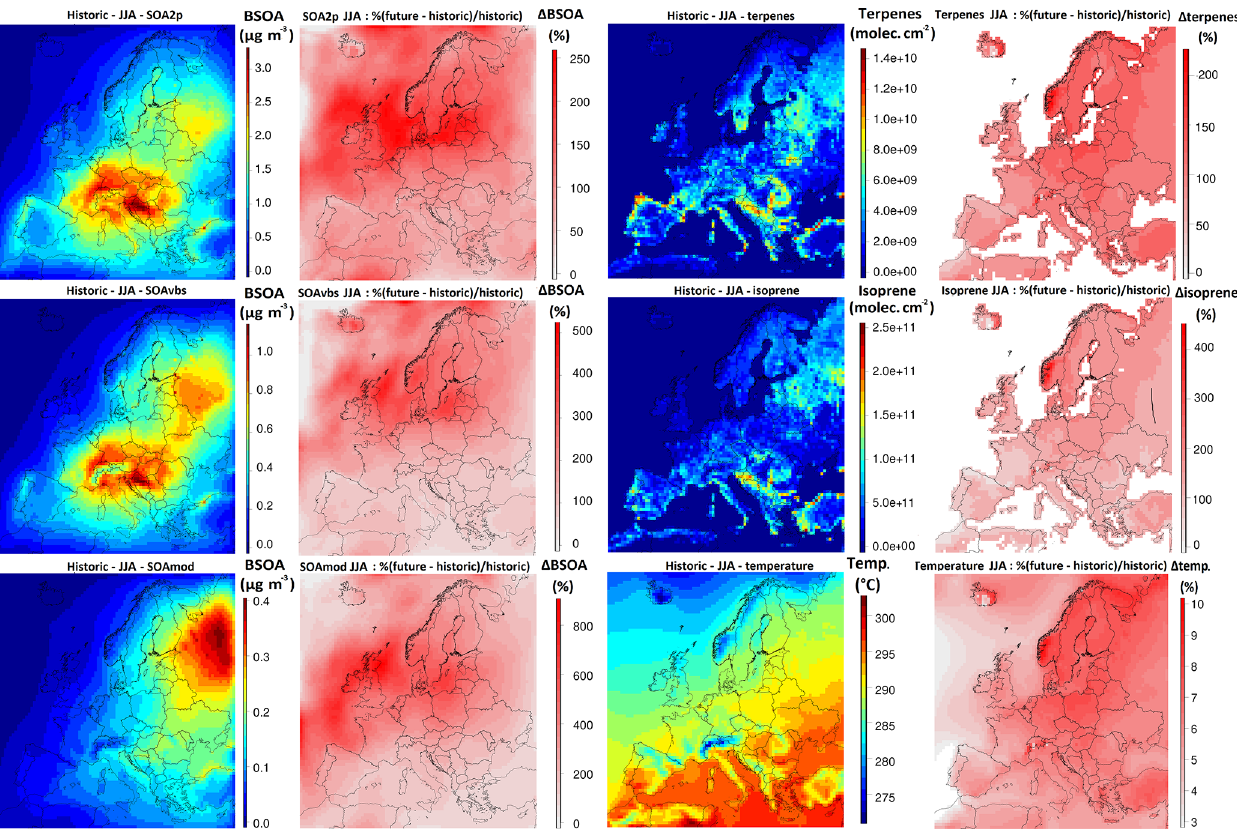
Figure 6. Averaged summer changes in concentrations of BSOA in historic (first column; µgm − 3 ) and their future changes (second column; % (future–historic) / historic) for all three scenarios (SOA2p, SOAvbs and SOAmod in first, second and third rows respectively). Third column shows the emissions of monoterpenes and isoprene (moleculescm − 2 yr − 1 ; first and second row) and temperature (K; third row)m and the changes of each one of these parameters is seen in fourth column (% (future–historic) / historic). Bear in mind that emissions of BVOCs and the temperature do not change between different schemes, scale for each plot is different, and all the figures are for the summer